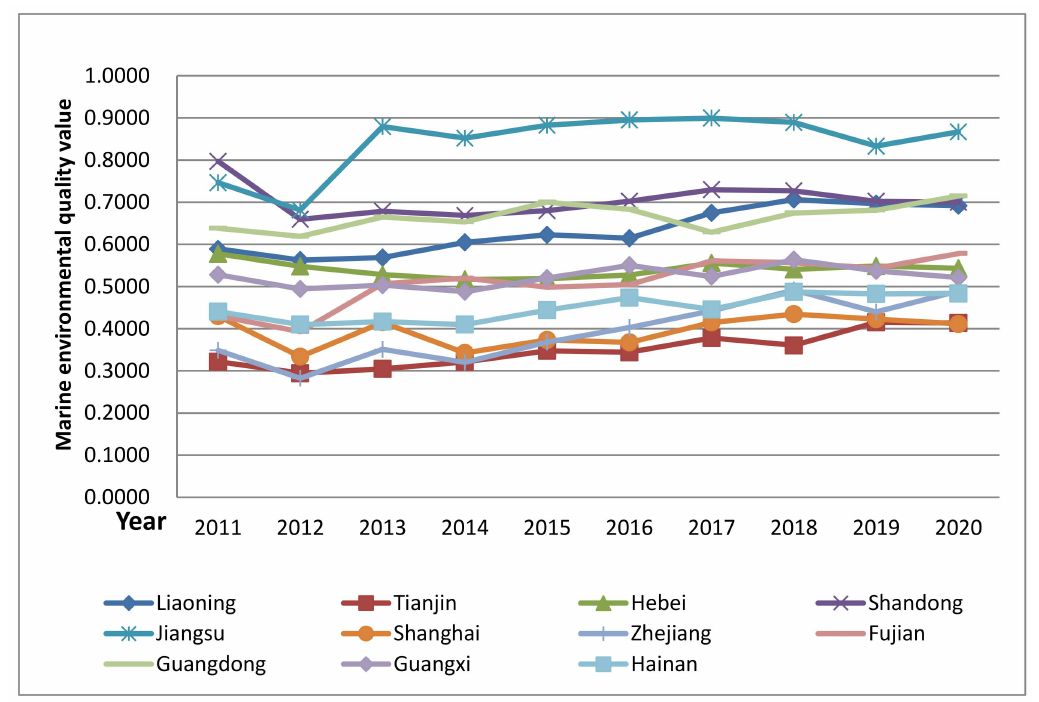
Figure 2. Changes in marine-environment quality